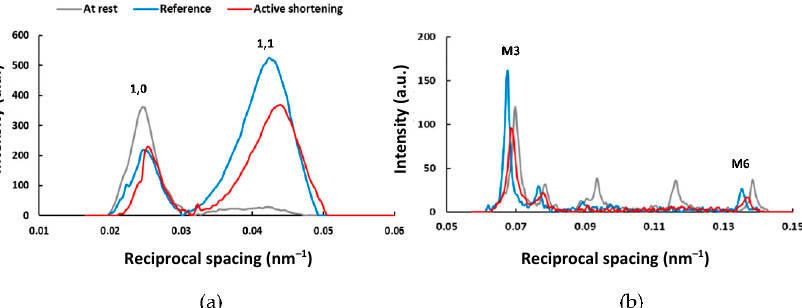
Figure 3. Typical 2D X-ray intensity peak profiles of the equatorial 1,0 and 1,1 and the meridional M3 and M6 reflections recorded at an average SL of 2.6 µm, at rest (gray), and at steady-state isometric contraction following a purely isometric reference contraction (blue) and an active shortening contraction (red). ( a ) X-ray intensity peak profiles of the equatorial 1,0 and 1,1 reflections; ( b ) X-ray intensity peak profiles of the meridional M3 and M6 reflections. Intensity peak profiles were determined in 10 bundles for three conditions (rest, reference, and active shortening). Bundles underwent individual X-ray exposures of 0.5 s in total, and the X-ray patterns were collected as a continuous series of 18 ms frames separated by 2 ms in order to minimize radiation damage. Int. J. Mol. Sci. 2021 , 22 , x FOR PEER REVIEW Active shortening did not affect the lattice spacing ( p = 0.99) but resulted in a reduc- tion in I 1,1 /I 1,0 ( p = 0 .036) compared to the purely isometric contraction (Figure 4a). The spacing of M3 and M6 and the peak intensity of M3 meridional reflections were signifi- cantly reduced ( p = 0.021, 0.048, and 0.024, respectively) after active shortening compared to the purely isometric contraction (Figure 4b,c).